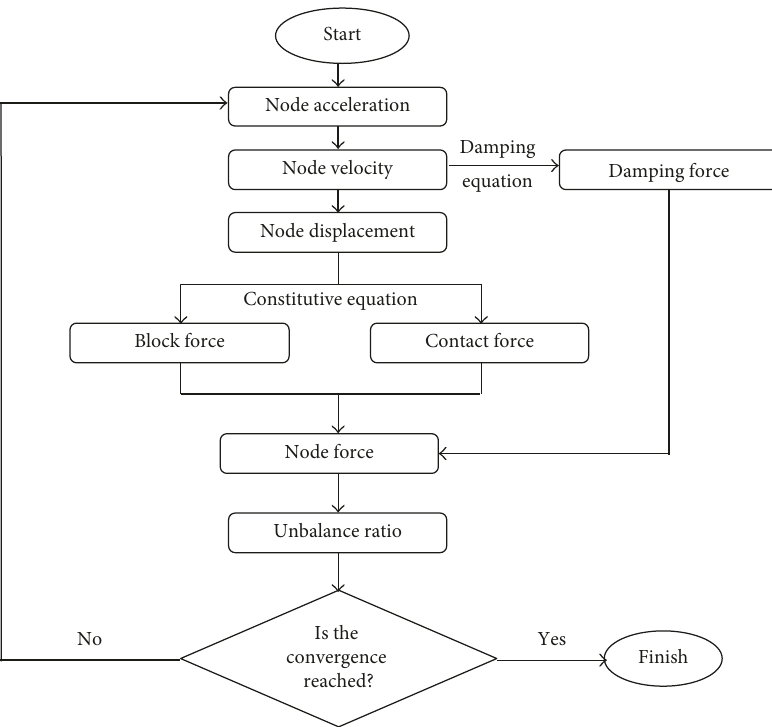
Figure 3: Main process to solve a problem.